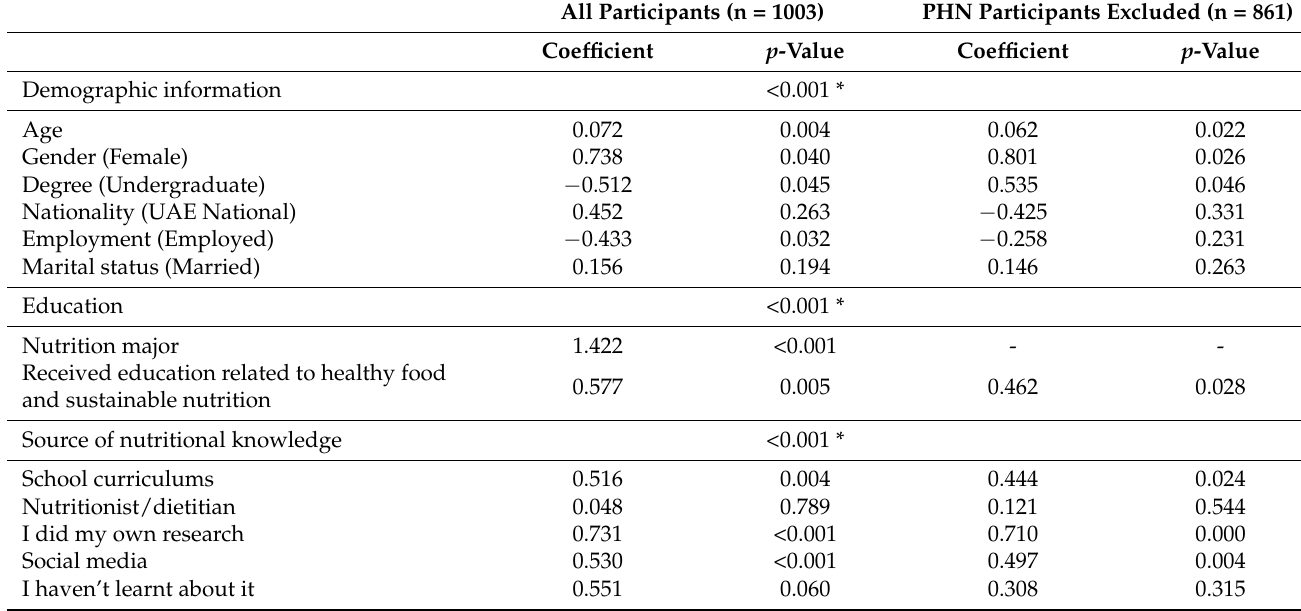
Table 5. Multiple regression models to identify the determinants of nutritional